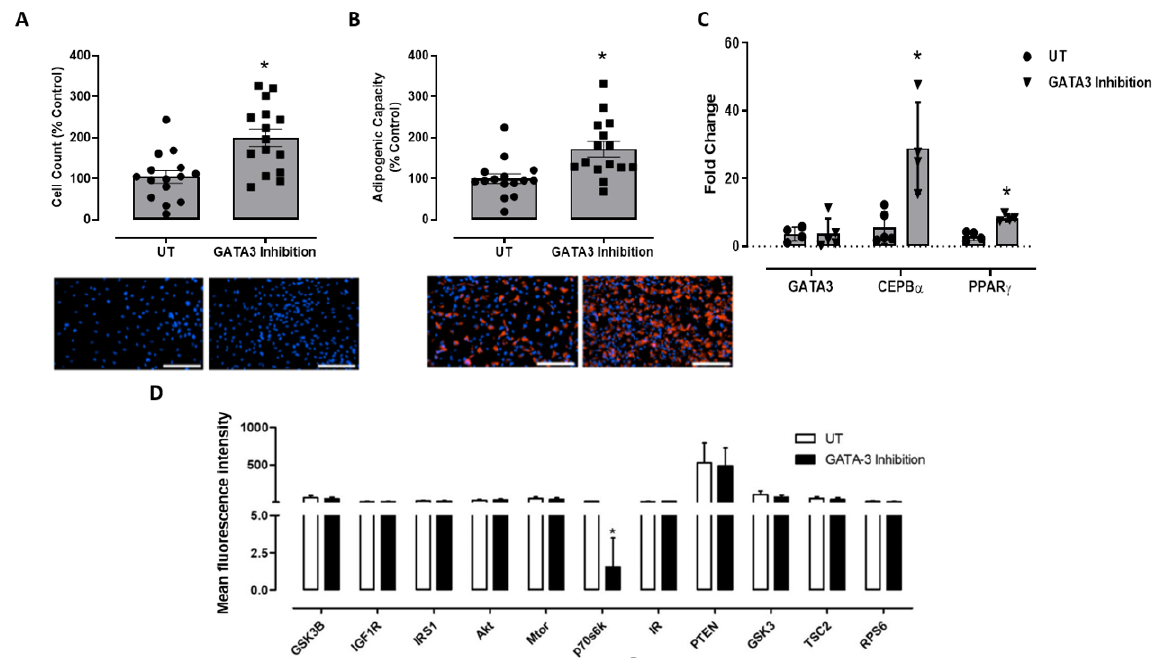
Figure 1. Effect of GATA3 inhibition on primary adipocytes ( A ) proliferation, ( B ) adipogenic capacity, ( C ) gene expression, and ( D ) insulin signaling. Data are presented as mean ± SEM with representative images below each bar ( A , B ). The tests were conducted on 4 independent biological replicates, with at least 3 technical replicates of each. Statistical analysis for effect of GATA3 inhibition was determined by Mann–Whitney U test (* p < 0.05) for ( A – C ) and two-way ANOVA followed by Bonferroni Posttests (* p < 0.05) for ( D ). Scale bars represent 200 μ m.